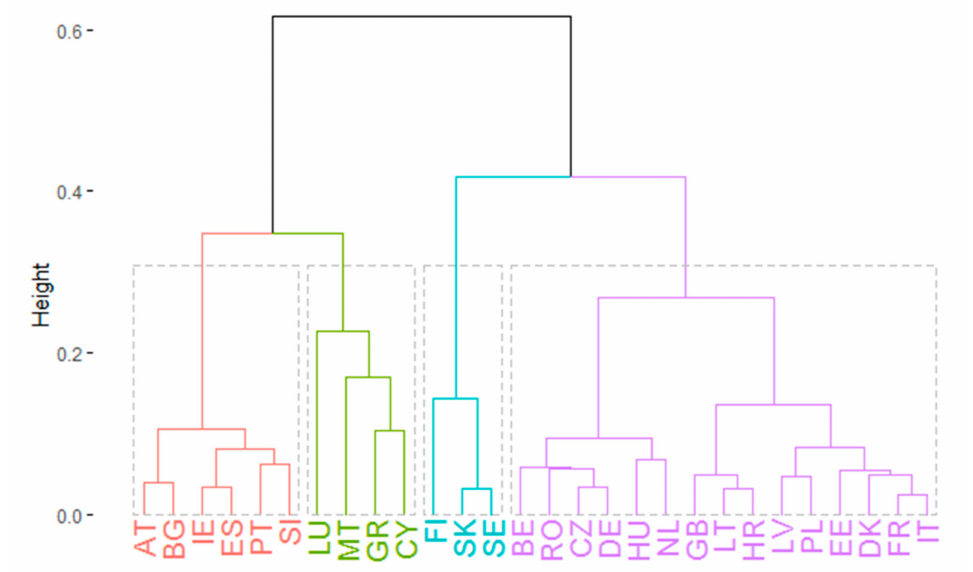
Figure 14. The dendrogram of hierarchical clustering using Ward’s method for countries from EU. Countries tagged using ISO Alpha-2 codes. Source: own